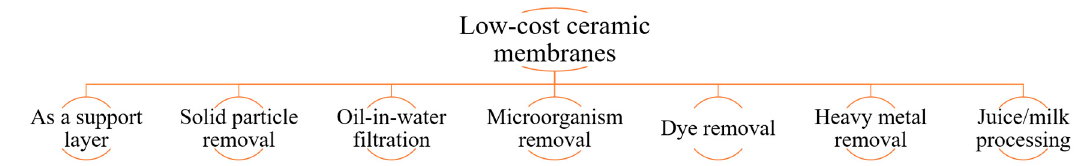
Figure 10. Various application areas of low-cost ceramic membranes.